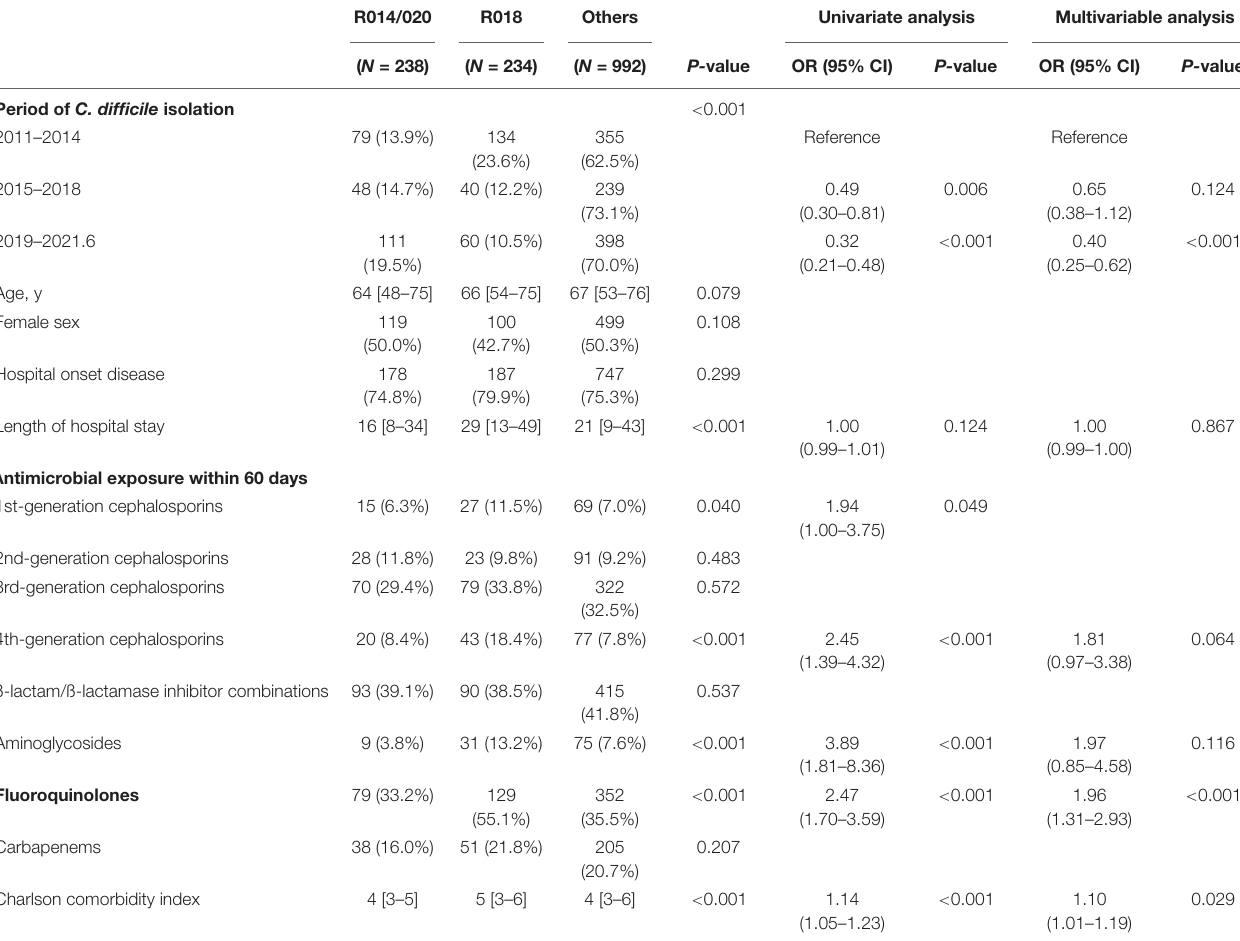
TABLE 4 | Comparison between the two most common ribotypes and the type of antibiotic used within 60 days before the CDI diagnosis. R014/020